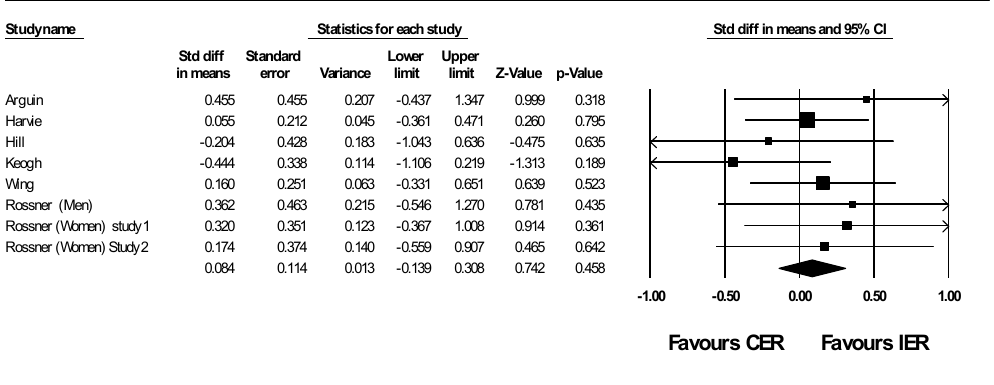
Figure 3. Meta-Analysis: Mean difference in weight loss after IER relative to CER arms within Figure 3. Meta ‐ Analysis: Mean difference in weight loss after IER relative to CER arms within each study. each